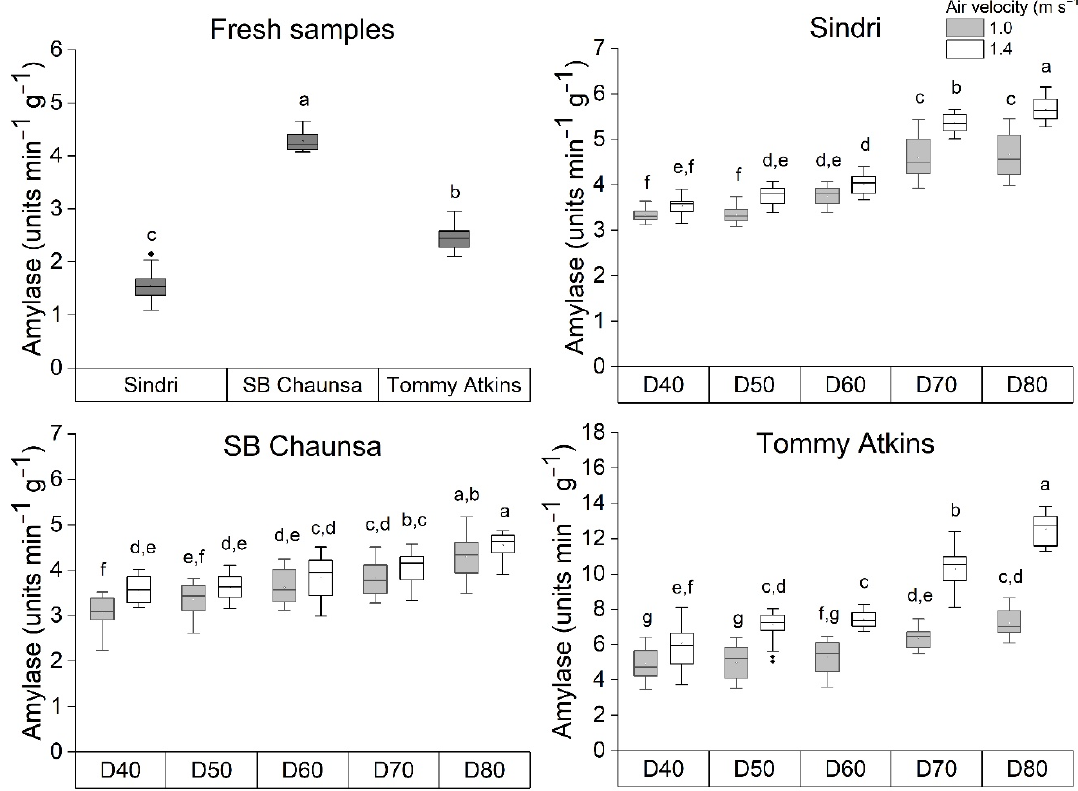
Figure 1. Amylase activity in fresh and dried mango of the varieties Sindri, SB Chaunsa, and Tommy Atkins; D = dried samples at temperatures 40 °C to 80 °C. a–g, different letters in the box plot indicate significant differences p < 0.05, ( n = 20 × 3).